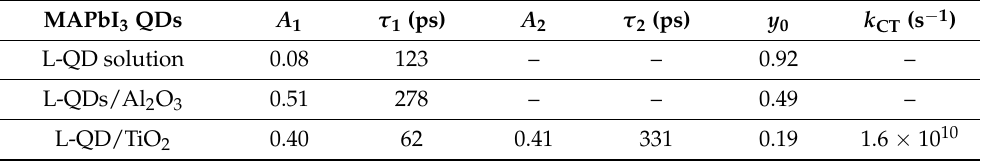
Figure 7. ( a ) The transient absorption (TA) kinetics of large size of MAPbI 3 QDs under different excitation intensities (1.5~119 µ J/cm 2 ), fast decay processes of TA responses appear when the excitation intensity is larger than 3.0 µ J/cm 2 , and become significant as the intensity increases. TA spectra of various sizes of ( b ) MAPbI 3 QDs dispersed in hexane, ( c ) QDs/Al 2 O 3 , ( d ) QDs/TiO 2 recorded at 5 ps and excited at 470 nm with an excitation intensity of 1.5 µ J/cm 2 . TA decay curves of ( e ) large, ( f ) medium and ( g ) small QD colloidal solution, attached on TiO 2 and Al 2 O 3 . ( h ) Charge transfer rate constant ( k CT ) of MAPbI 3 QDs as a function of the free energy change ( − ∆ G ). Table 3. The fi tt ed parameters of TA kinetics for various size of MAPbI 3 QD colloidal solution, QDs/TiO 2 and QDs/Al 2 O 3 . The decay curves were fi tt ed by single-exponential ( y = y 0 + A 1 exp ( − t / τ 1 )) or biexponential model ( y = A 1 exp ( − t / τ 1 ) + A 2 exp ( − t / τ 2 ) + y 0 ), where y 0 , A 1 , A 2 are constant, τ 1 and τ 2 represent lifetime, t is time.